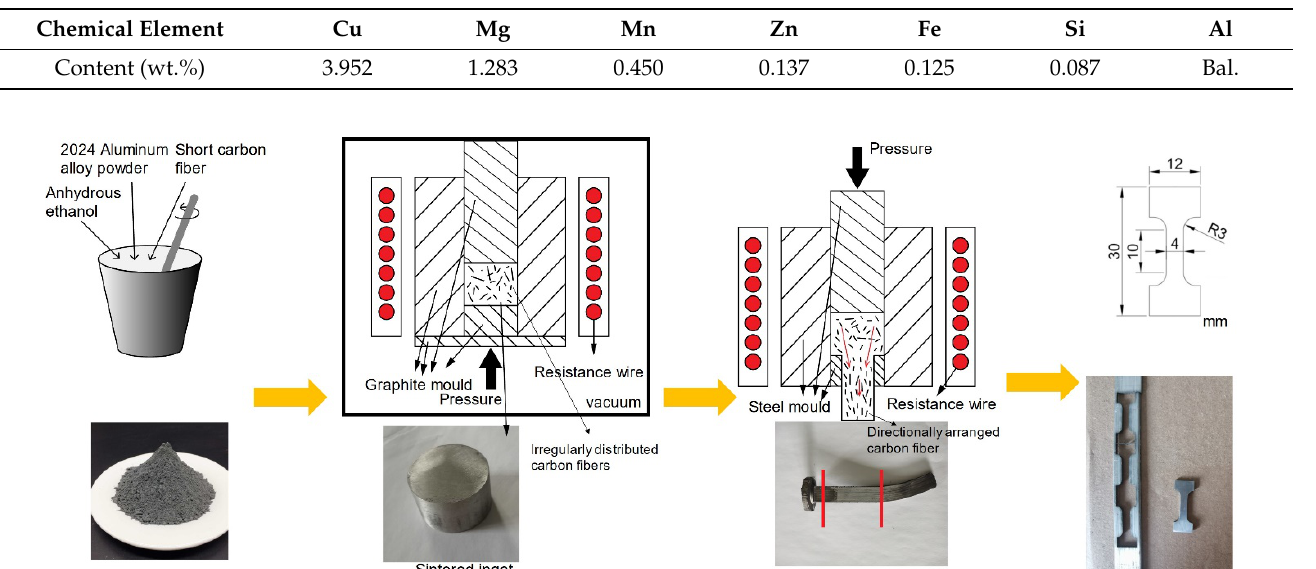
Table 1. Chemical composition of the as-received 2024 Al powder (wt.%).